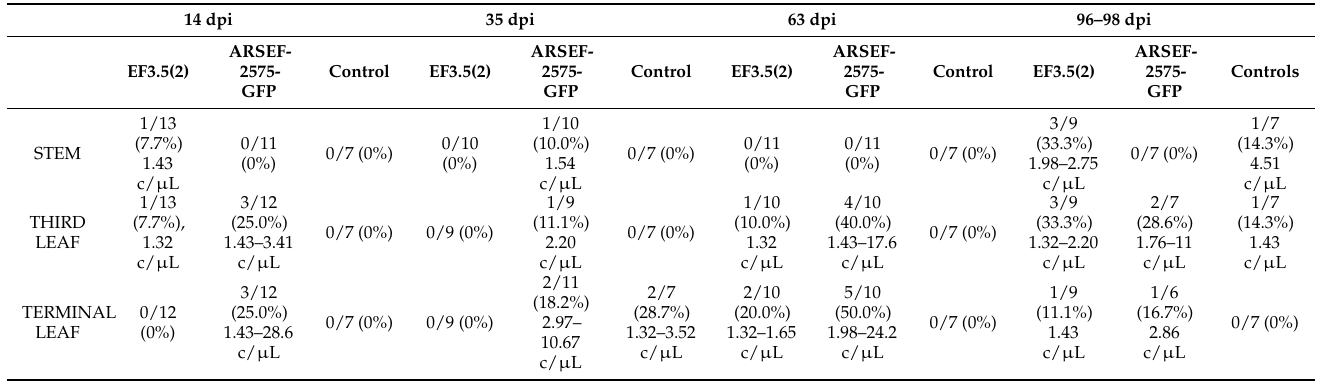
Table A1. Detection of M. robertsii DNA copies in aboveground grapevine tissue (stem, third leaf, terminal leaf) 14-, 35-, 63- and 96–98 days post inoculation (dpi) after watering roots with a conidial suspension of two M. robertsii strains (EF3.5(2) and ARSEF-2575-GFP). Presented are the number of positive plants in relation to the total number of plants (or percentage positive plants) and the copy numbers/ µ L sample (or range of copy numbers) determined via ddPCR. Control plants were treated with the same volume of a sterile suspension